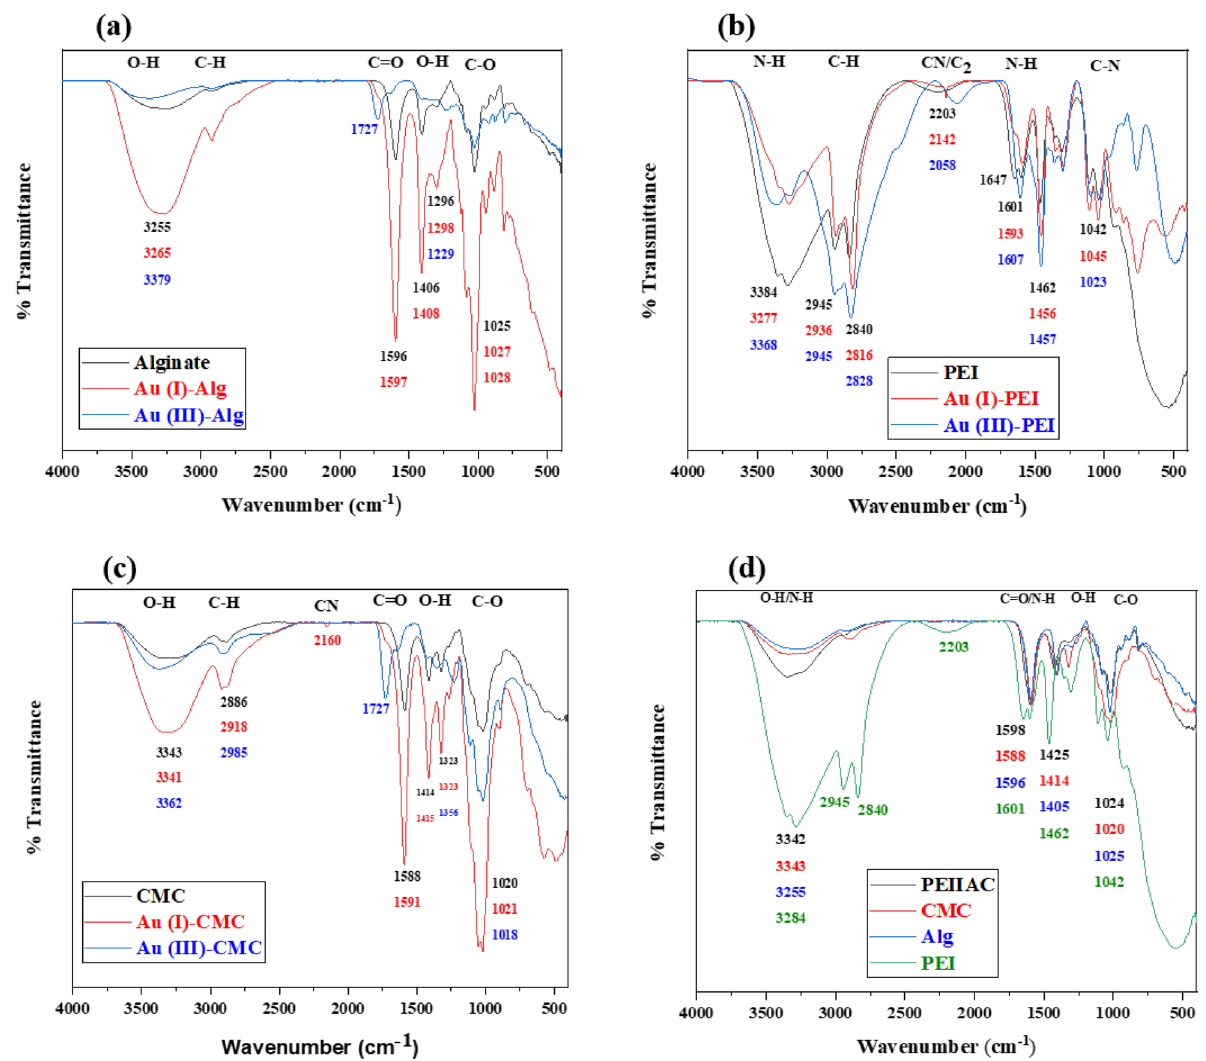
Figure 6. FTIR spectra of ( a ) Au–Alginate, ( b ) Au-PEI, ( c ) Au-CMC, and ( d ) PEIIAC, CMC, Alg and PEI.